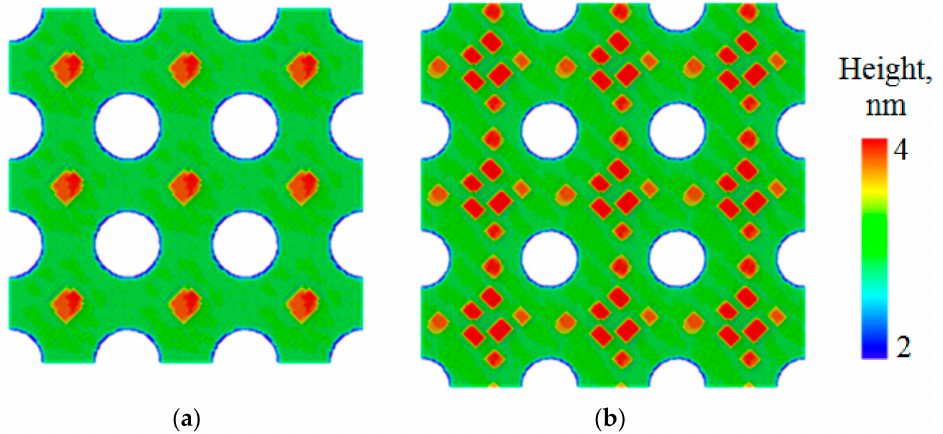
Figure 3. Simulated arrangement of 3D Ge islands nucleated in periodic structure with infinitely deep pits depending on the distance between them. The distance between the pits is 24.5 nm ( a ) and 31.5 nm ( b ). The growth temperature is 450 ◦ C. The rate of Ge deposition is 0.1 ML/s. The amount of Ge was 10 ML for ( a ) and 6 ML for ( b ). The pit diameter is 13.6 nm. All sizes are scaled down by the factor of 35 with respect to the experimental